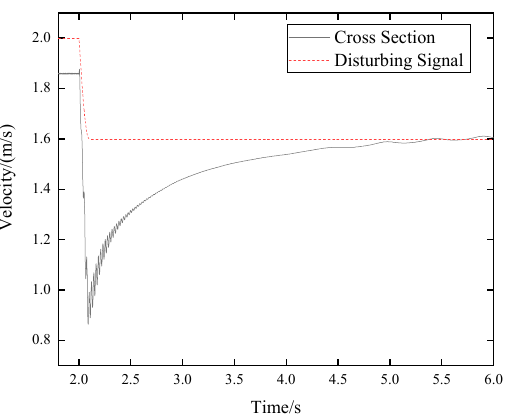
Figure 14. Flow velocity variation curve of the leakage hole A cross ‐ section.